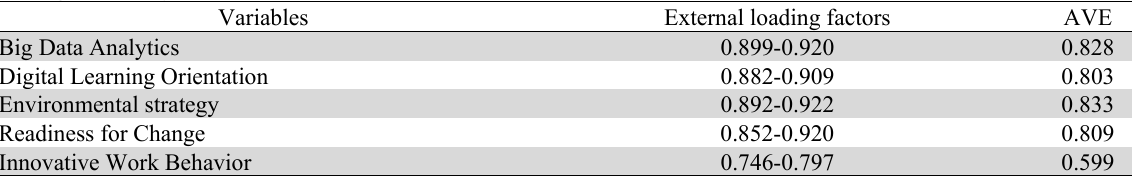
Convergent validity